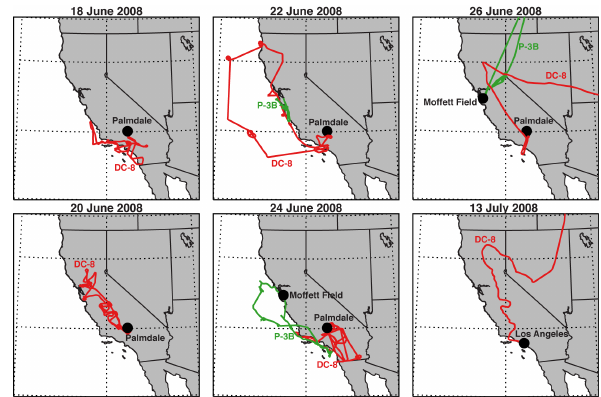
Figure 1c. Flight tracks for the ARCTAS-CARB deployment (Table 5a-b). Fig. 1c. Flight tracks for the ARCTAS-CARB deployment (Ta- bles 5a–b).